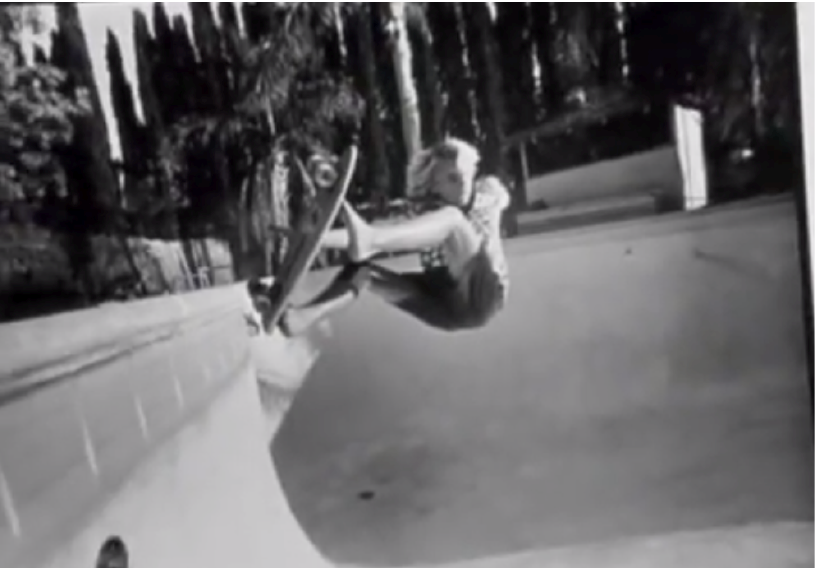
Figure 2. Skater in pool with Cyprus